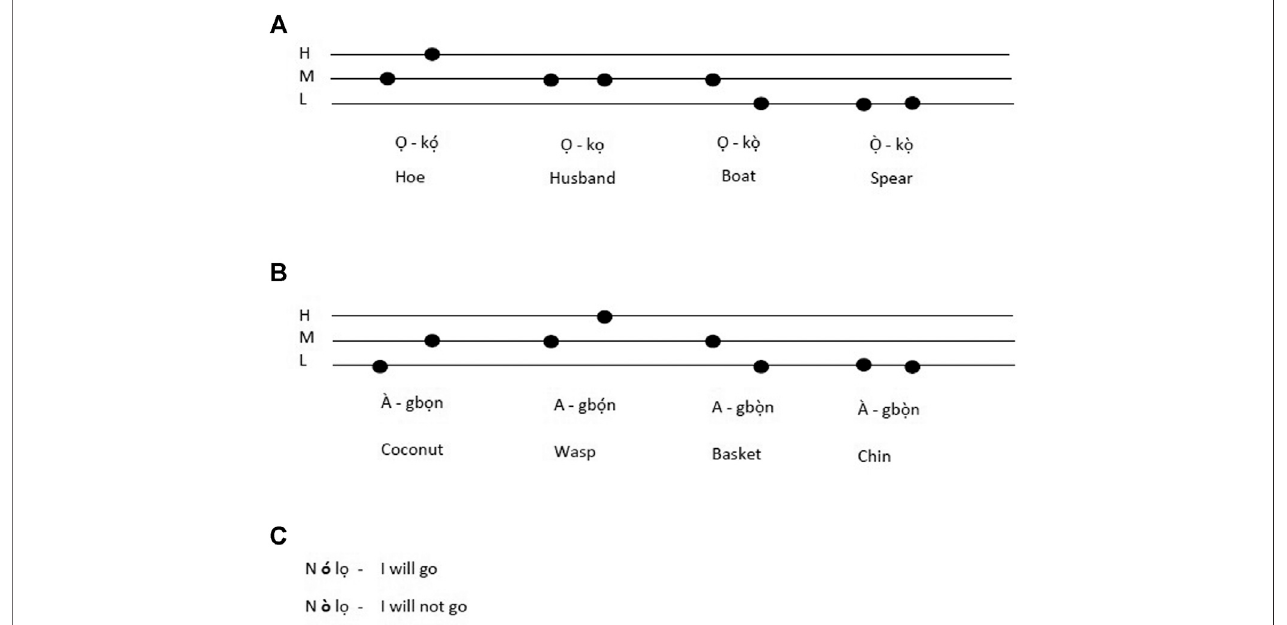
FIGURE 2 | Three examples exemplifying various standard f 0 glide patterns of the Yorùbá